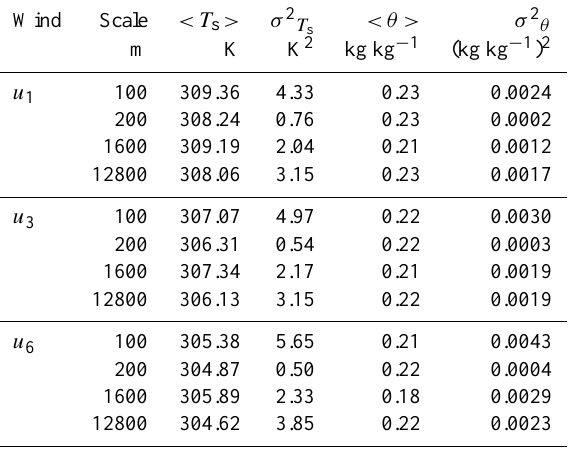
Table 1. Spatial means and variances for surface temperature ( T s